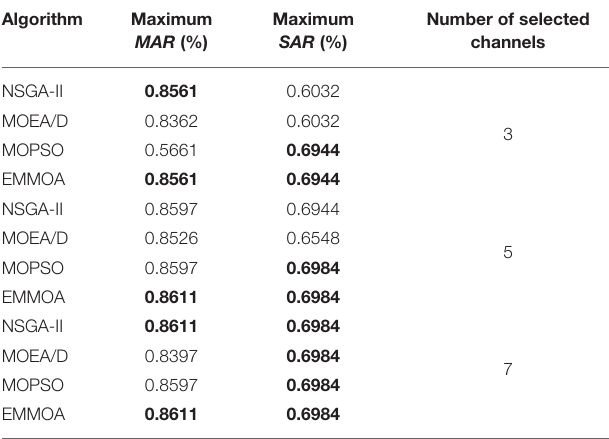
TABLE 2 | Classification accuracies for each subject by using all channels and the selected channels obtained by EMMOA.